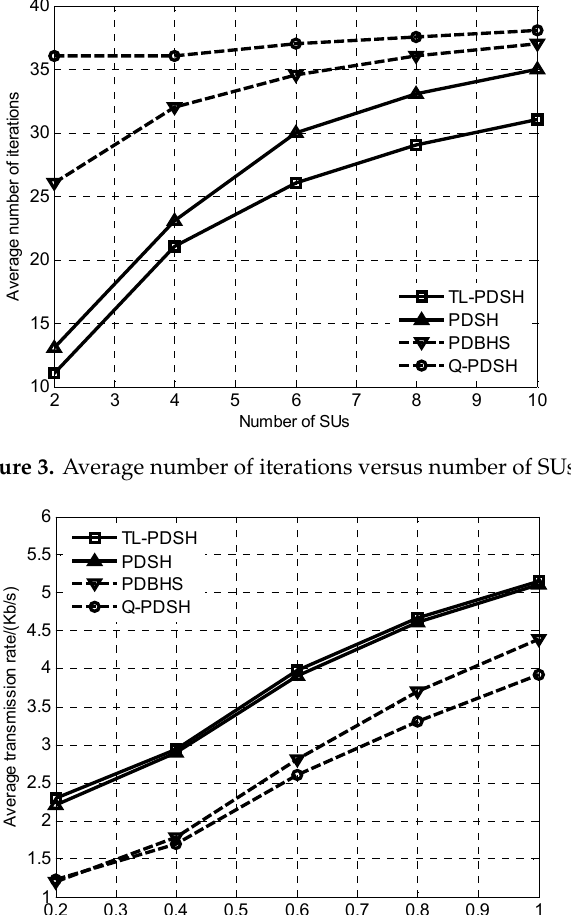
Figure 3. Average number of iterations versus number of SUs.